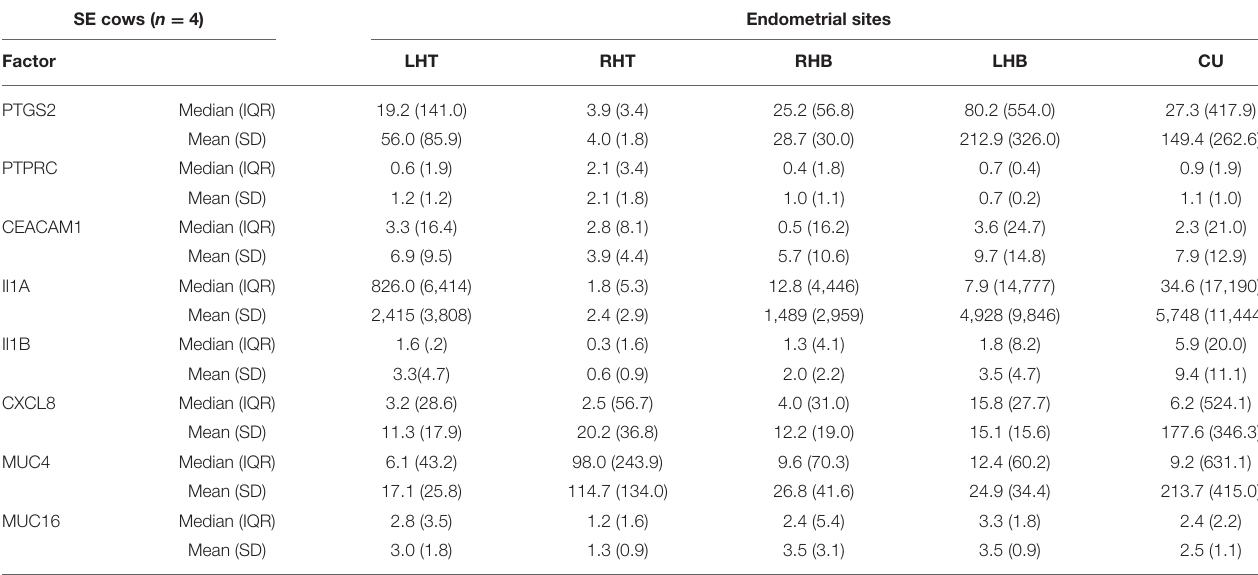
TABLE 2 | Median, interquartile range (IQR), mean, and standard deviation (SD) of normalized mRNA expression for different pro-inflammatory factors and mucins in the endometrium at the corpus uteri (CU), the base of the left horn (LHB), the tip of the left horn (LHT), the base of the right horn (RHB) and the tip of the right horn (RHT) collected from four cows with subclinical endometritis (SE) on day 28 to 34 postpartum.